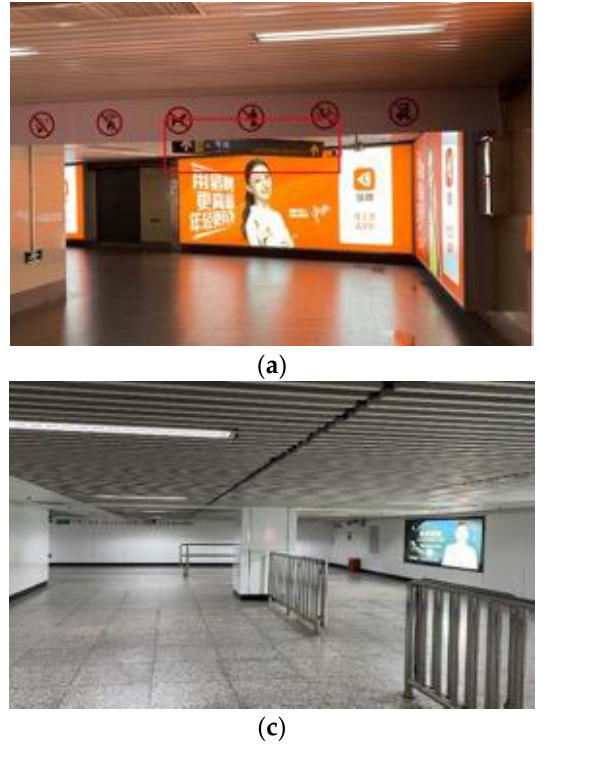
Figure 10. The evaluation results of the evaluation index of the convenience of the transfer space environments of sample stations.